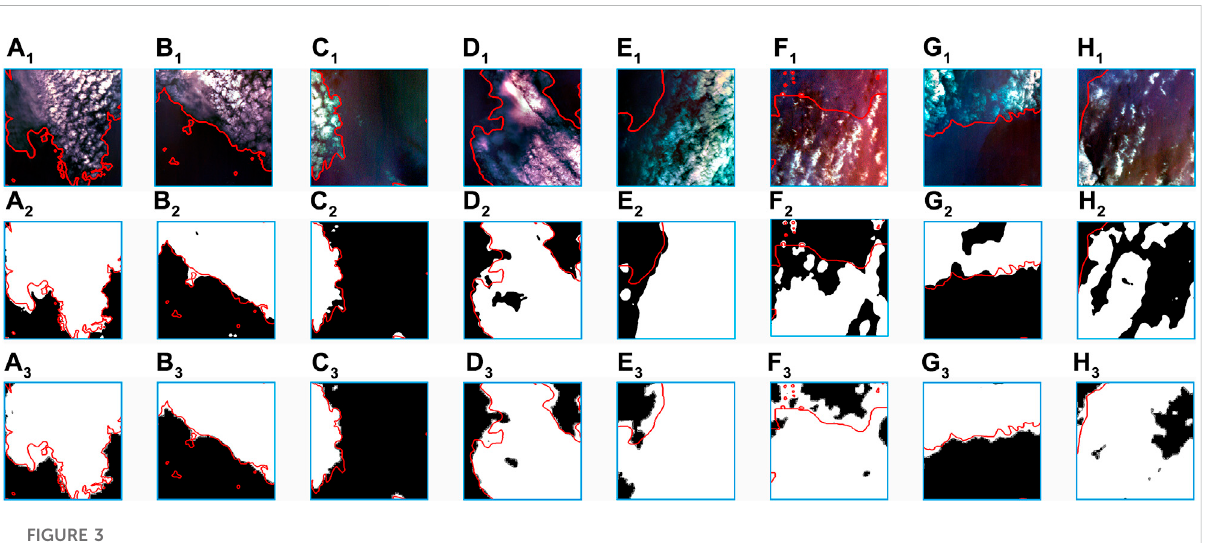
FIGURE 3 Cloud detection results, in which white is the cloud pixels, black is the clear sky pixels, and the red curve is the visually interpreted cloud boundary.The fi rstrowistheoriginalimage,thesecondrowistheresultbasedontheVGGweightsdetection,andthethirdrowistheresultusingthe Resnet50 weights detection. (A – H) are slice images with a size of 512*512.